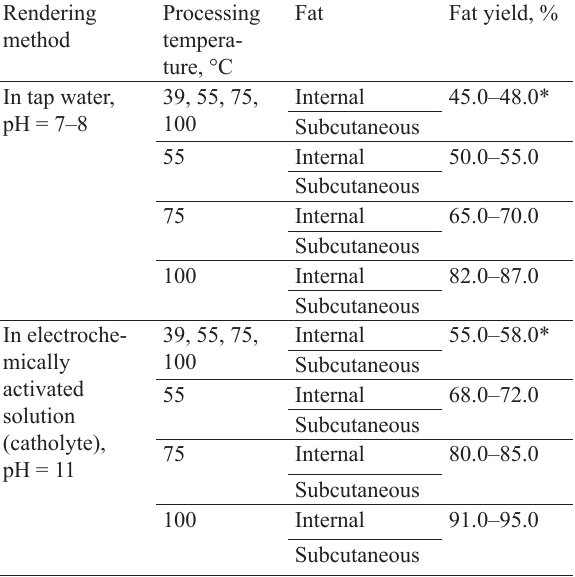
Table 4 Fat yield at various processing methods Table 5 Variation of factors for fat rendering